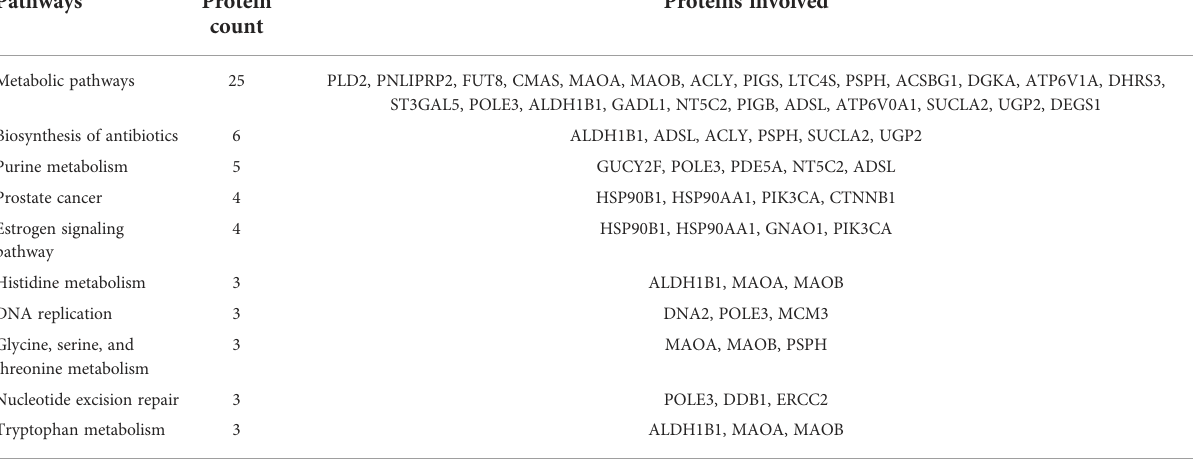
TABLE 3 Top 10 dysregulated pathways between fresh and cryopreserved spermatozoa and the associated proteins.